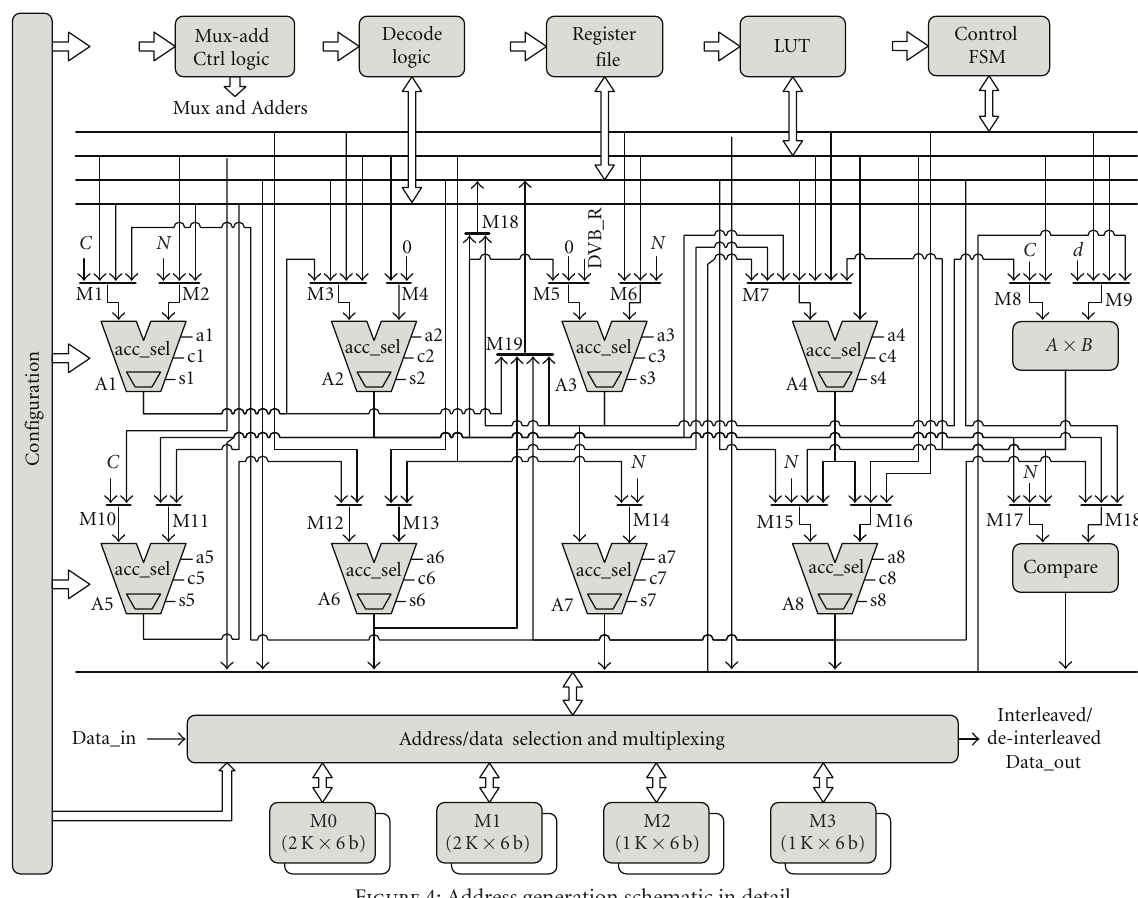
Figure 4: Address generation schematic in